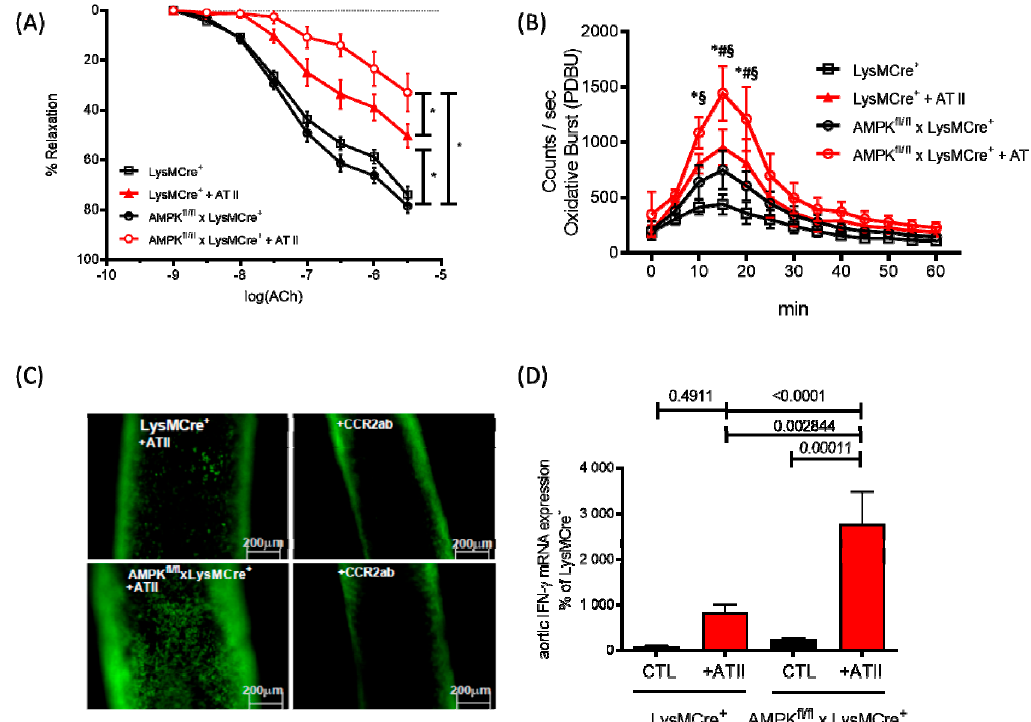
Figure 4. Functions of monocyte-specific α 1AMPK. ( A ) Endothelial-dependent relaxation in response to acetylcholine was analyzed by isometric tension studies in intact aortic rings from myelomonocytic cell-specific α 1AMPK knockout mice ( α 1AMPK fl / fl LysM-Cre) and corresponding wild-type littermates (LysMCre / wt) treated with AT II (1.0 mg / kg for 7 days; n = 8–10 mice / group). ( B ) Phorbolester (PDBu)-stimulated oxidative burst in whole blood was determined by L-012-enhanced chemiluminescence ( n = 12). * p < 0.05 vs LysMCre + CTL, § p < 0.05 vs. AMPK fl / fl x LysMCre + , # p < 0.05 vs. LysMCre + + AT II. ( C ) Epifluorescence intravital microscopy was used to visualize adherent and rolling leucocytes in carotid arteries. Nucleated cells were stained with acridine orange (green fluorescence). Representative images of carotid arteries after 7 days of continuous AT II infusion ( n = 8), before and 60 min after single intraperitoneal injection of anti-CCR2 antibody (CCR2ab). ( D ) Pro inflammatory cytokine level of IFN- γ was measured by real-time PCR ( n = 10). Data were reused from [103] with permission. Copyright © 2018, Oxford University Press. Abbreviations: AMPK: adenosine monophosphate-activated protein kinase; AT II: angiotensin II; CCR-2: C-C motif chemokine receptor